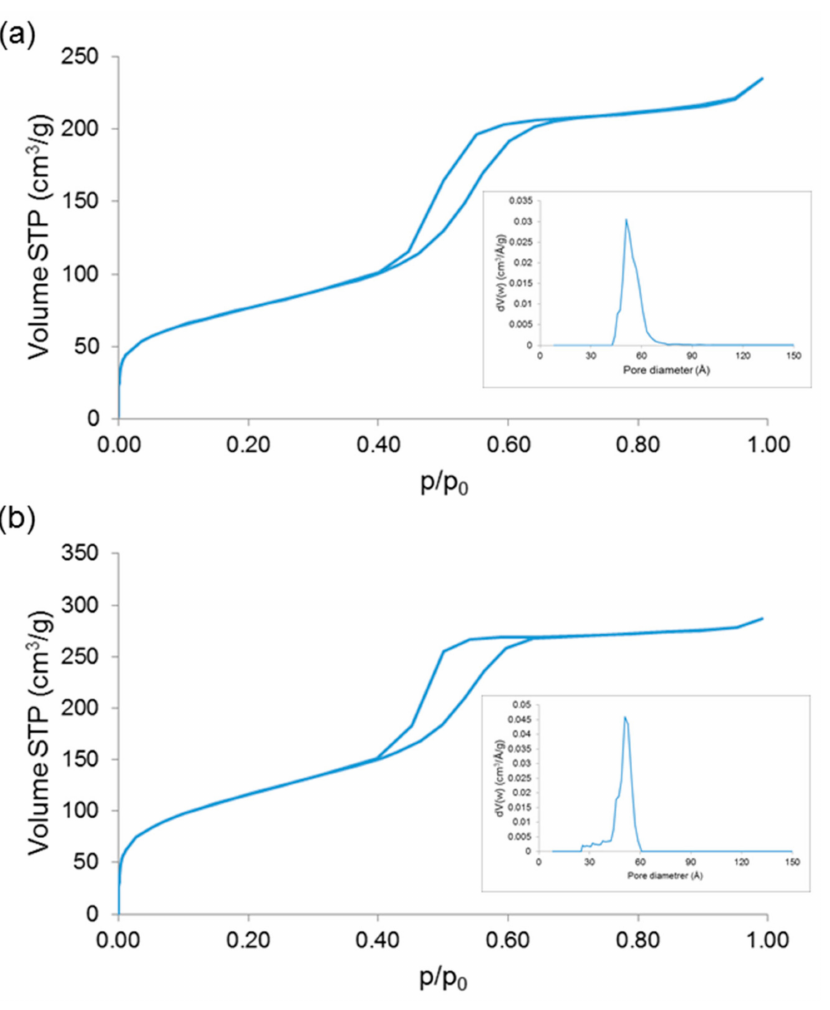
Figure 8. Nitrogen adsorption-desorption isotherms of ( a ) 1Cu-MBG and ( b ) 5Cu-MBG. Insets in both pictures report the pore size distribution. Table 1. Textural parameters obtained by nitrogen adsorption-desorption porosimetry for the calcined mesoporous